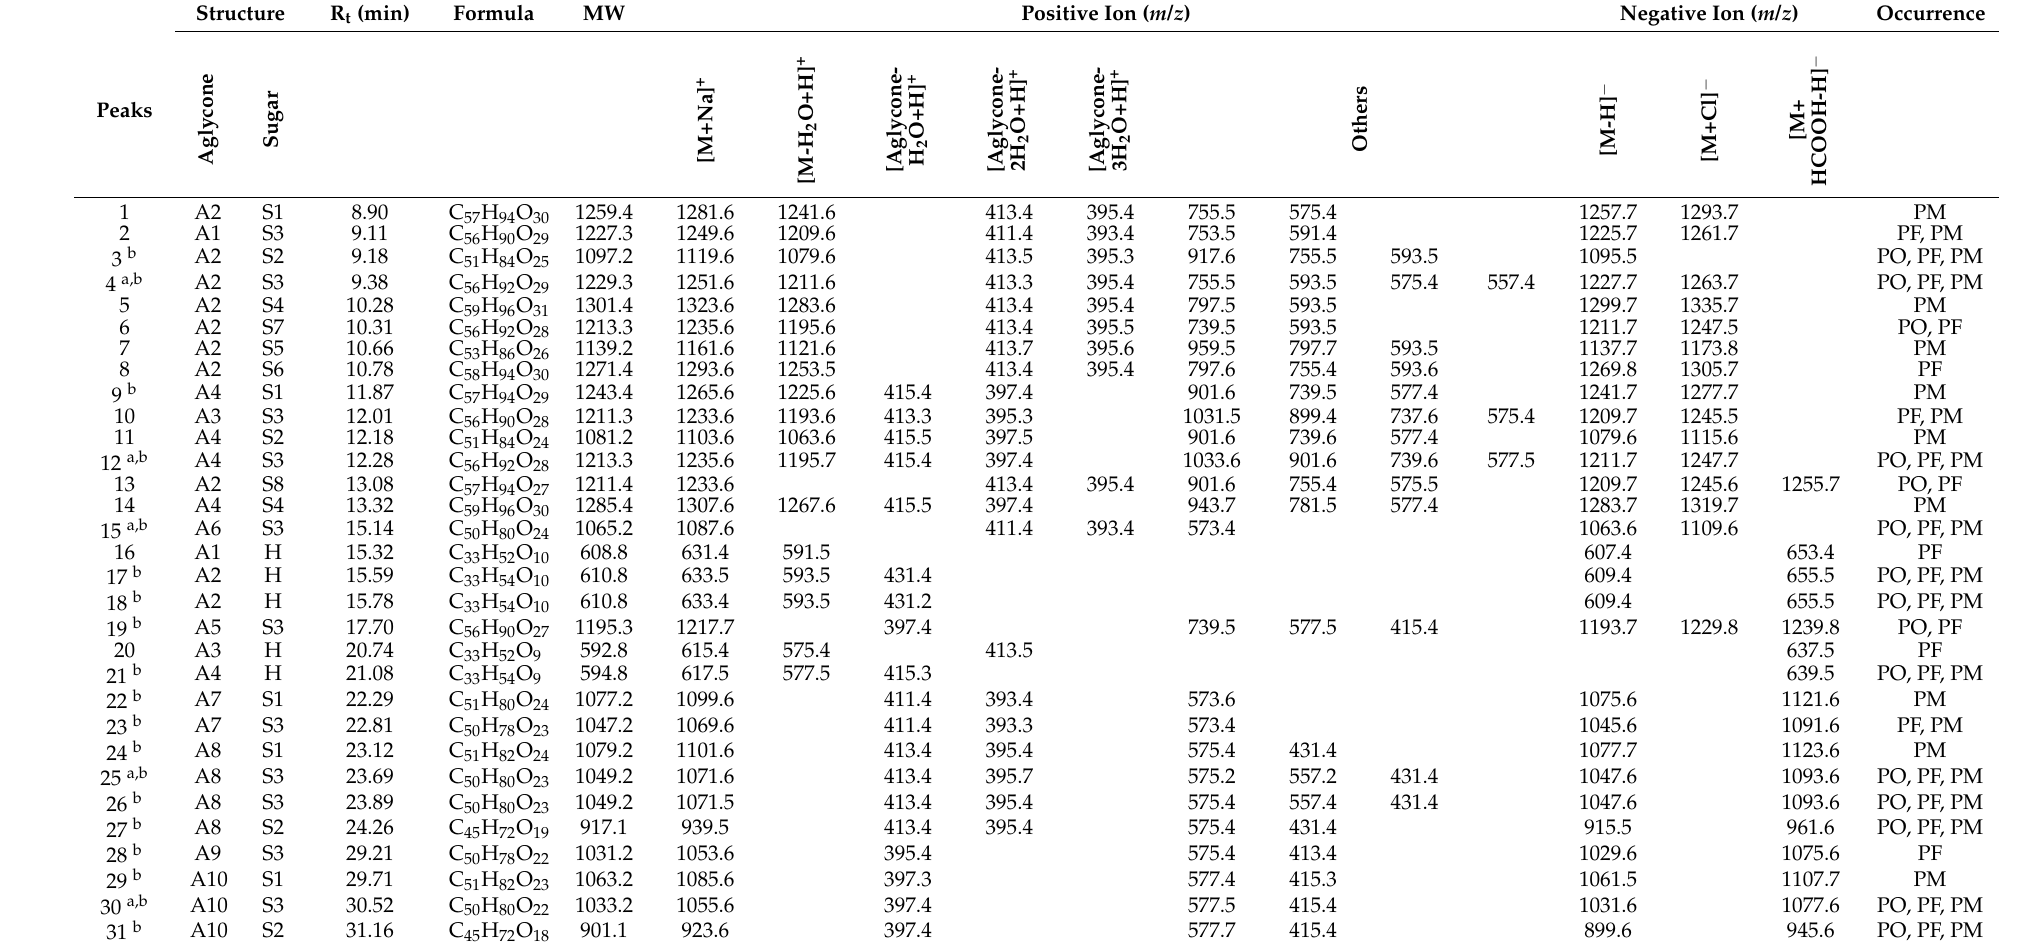
Table 1. Steroidal saponins detected from Polygonatum plants by LC-ESI-MS analysis.